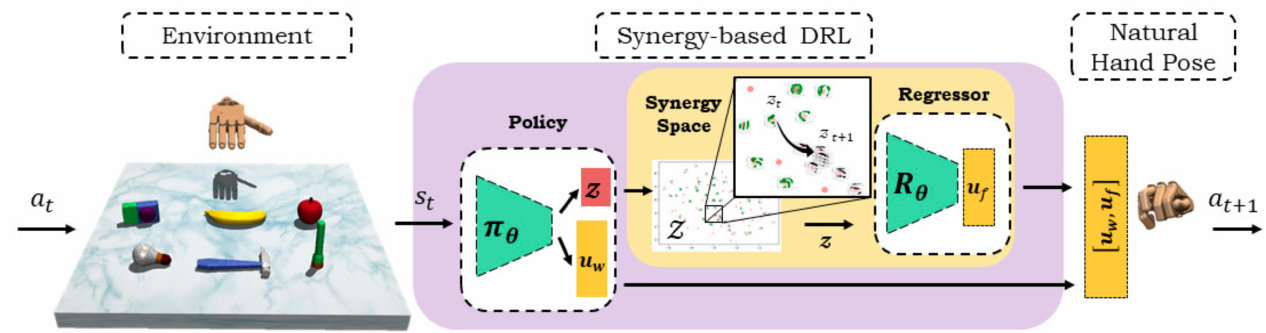
Figure 1. The proposed synergy–based DRL for natural object manipulation with a synergy space of object haptic informa- tion and a deep regressor to derive natural hand poses of the ADROIT anthropomorphic robotic